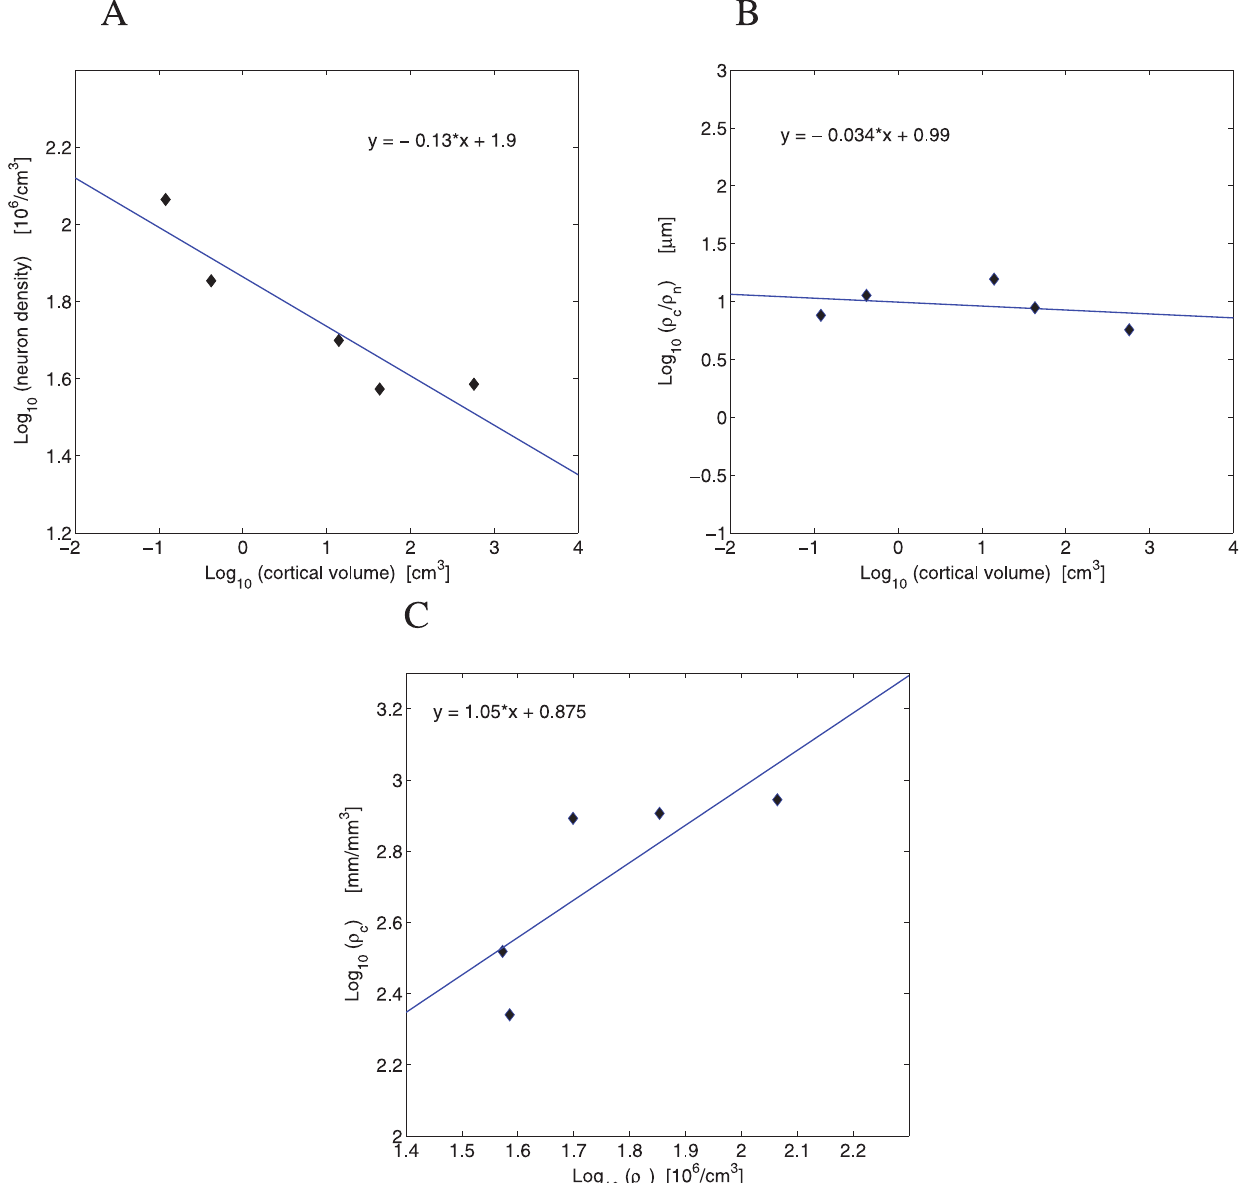
Figure 4. Neuron density versus capillary length density in the cerebral cortex. (A) Across our sample of mammals, the cortical neuron number density r n scales against cortical volume with the exponent { 0 : 13 ( y ~{ 0 : 128 x z 1 : 86 , R 2 ~ 0 : 87 , p ~ 0 : 022 ), exponent CI=( 2 0.221, 2 0.036). (B) The ratio of the density of capillary length r c to the density of neurons r n in the cortex does not correlate with brain size ( y ~{ 0 : 034 x z 0 : 99 , R 2 ~ 0 : 09 , p ~ 0 : 617 ), exponent CI=( 2 0.228,0.161). (C) The log-log dependence of the capillary length density r c on neuron density r n gives the exponent of 1.05 ( y ~ 1 : 051 x z 0 : 88 , R 2 ~ 0 : 63 , p ~ 0 : 109